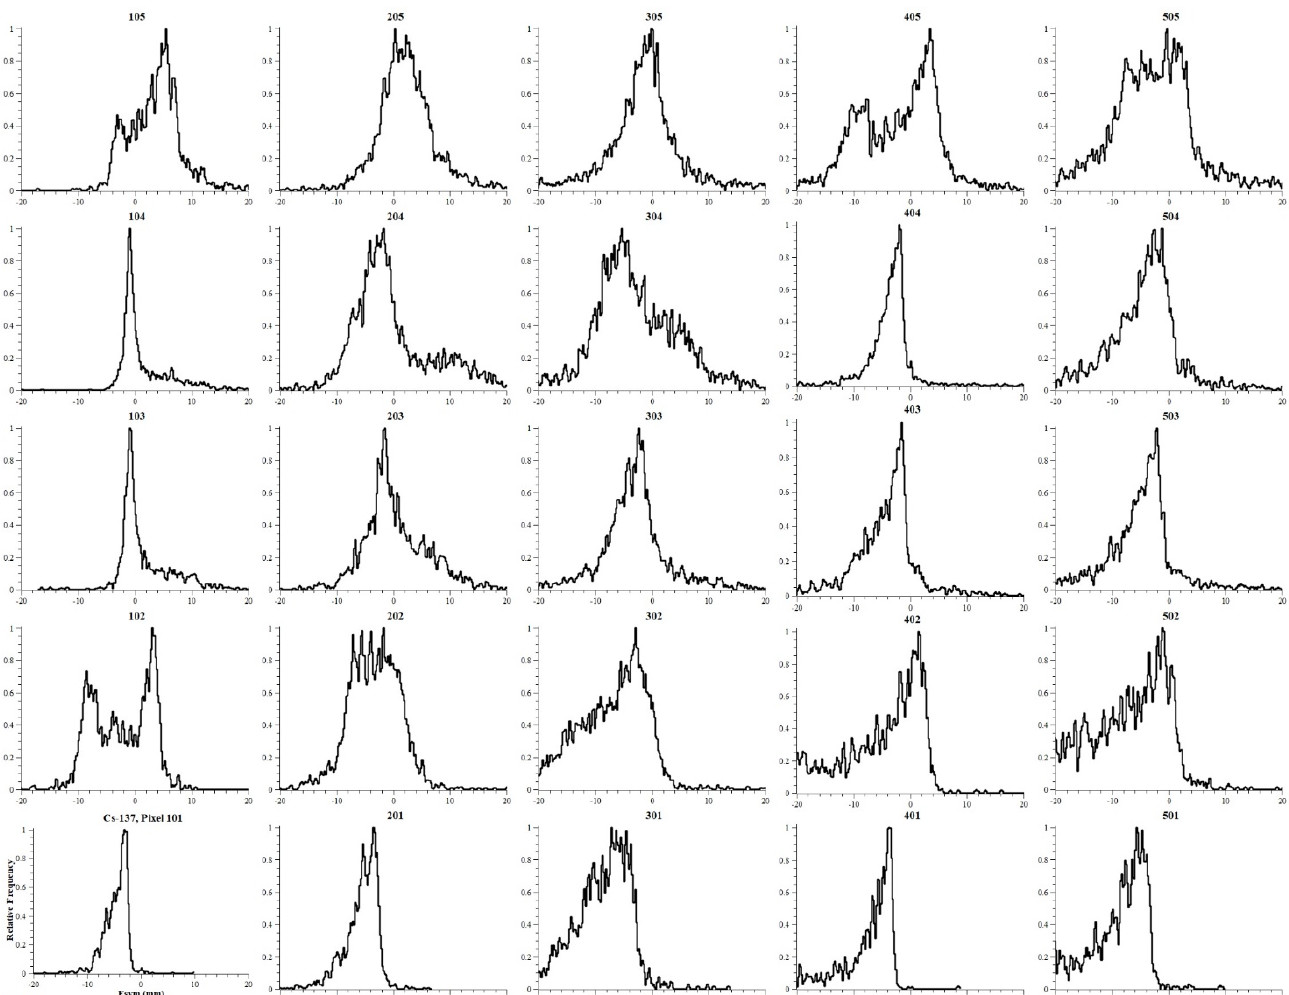
Figure A10. Fsym spectra per pixel for the first quarter of crystal-array under Cs-137 point-source irradiation. The first quarter includes the pixels with RR ≤ 5 and CC ≤ 5. The common axes and the plot descriptions are reported only once in the bottom-left frame. The spectra, obtained by building histograms from single-events Fsym values with 0.2 mm binning, have undergone smoothing for denoising data. The frequency values were normalized, pixel by pixel, to the respective maximum value.